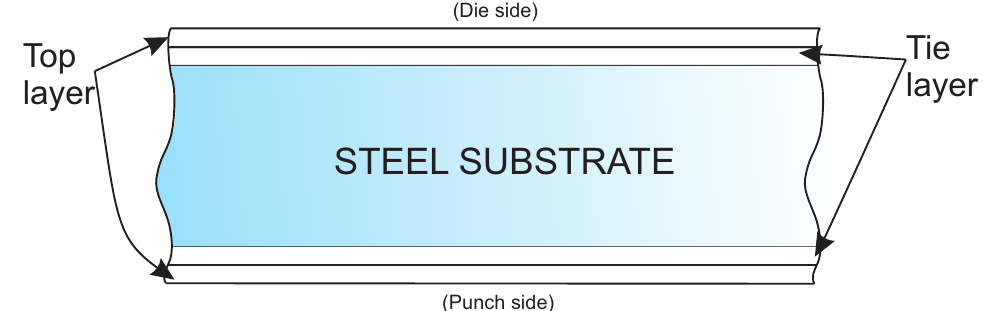
Figure 2. Illustration of the used material.